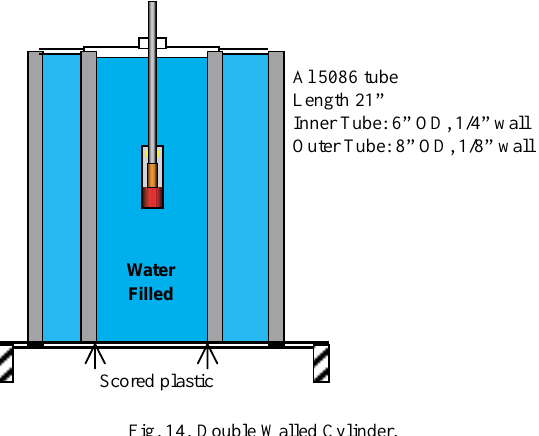
Fig. 14. Double Walled